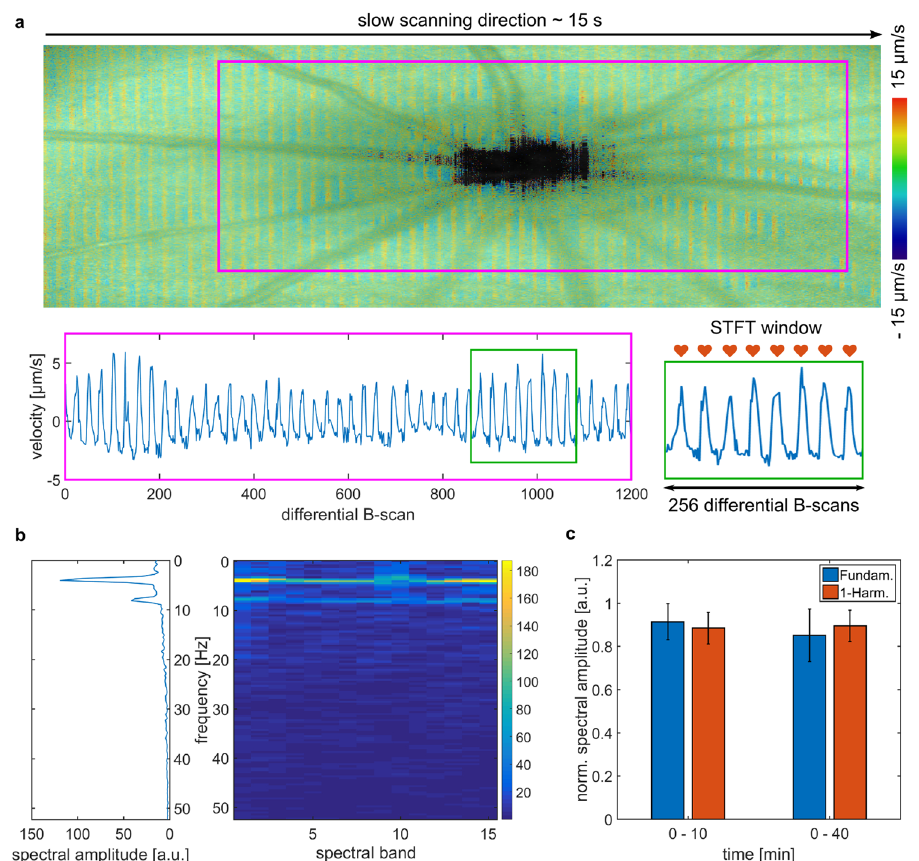
Figure 2. Fundus pulsation analysis and repeatability measurements. ( a ) An exemplary fundus pulsation map overlaid on the corresponding reflectivity en-face projection at physiological IOP. Fundus pulsations were determined as velocity between retinal and chorioscleral complex. The velocities were averaged for each B-scan and subsequently analyzed by a STFT within a sliding window depicted in green. ( b ) The spectrogram showing the 15 spectral bands determined by the STFT and average spectral amplitude for the fundus pulsations shown in ( a ). The average spectral amplitudes were calculated for the fundamental oscillation as well as for the first harmonic. ( c ) The repeatability was investigated in a short time range of approximately 10 minutes (3 measurements each) as well as on a longer time span of approximately 40 minutes (total of 5 measurements each) for three rats. The normalized mean spectral amplitudes of the fundamental oscillation as well as of the first harmonic are shown, where error bars indicate the standard